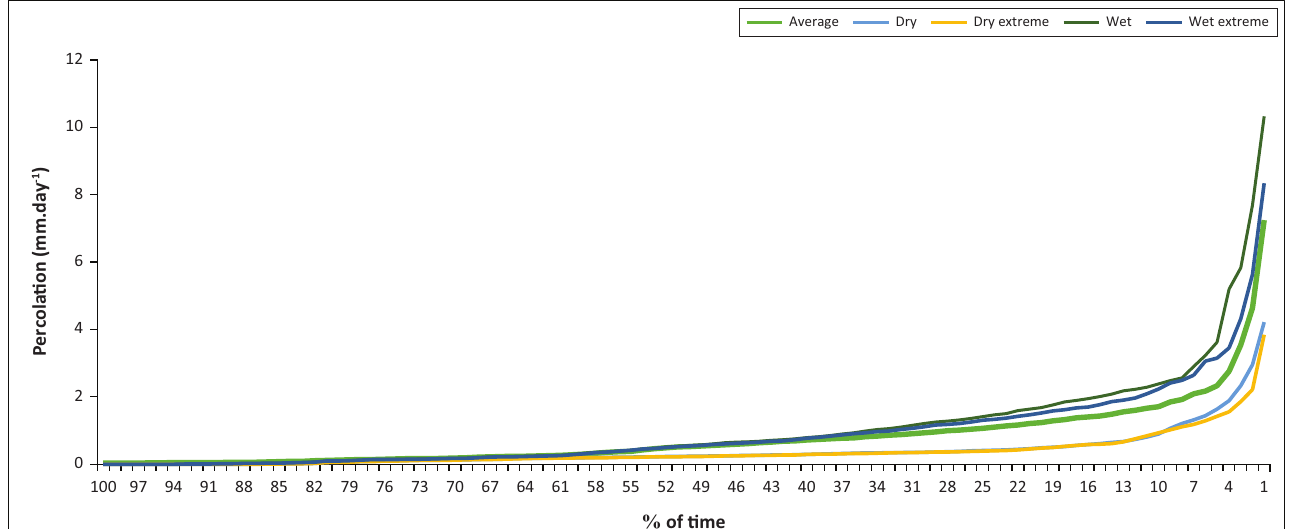
FIGURE 5: Duration of exceedance curves of percolation (mm day –1 ) from the lowest node of the Dundee soil in the riparian zone under different precipitation